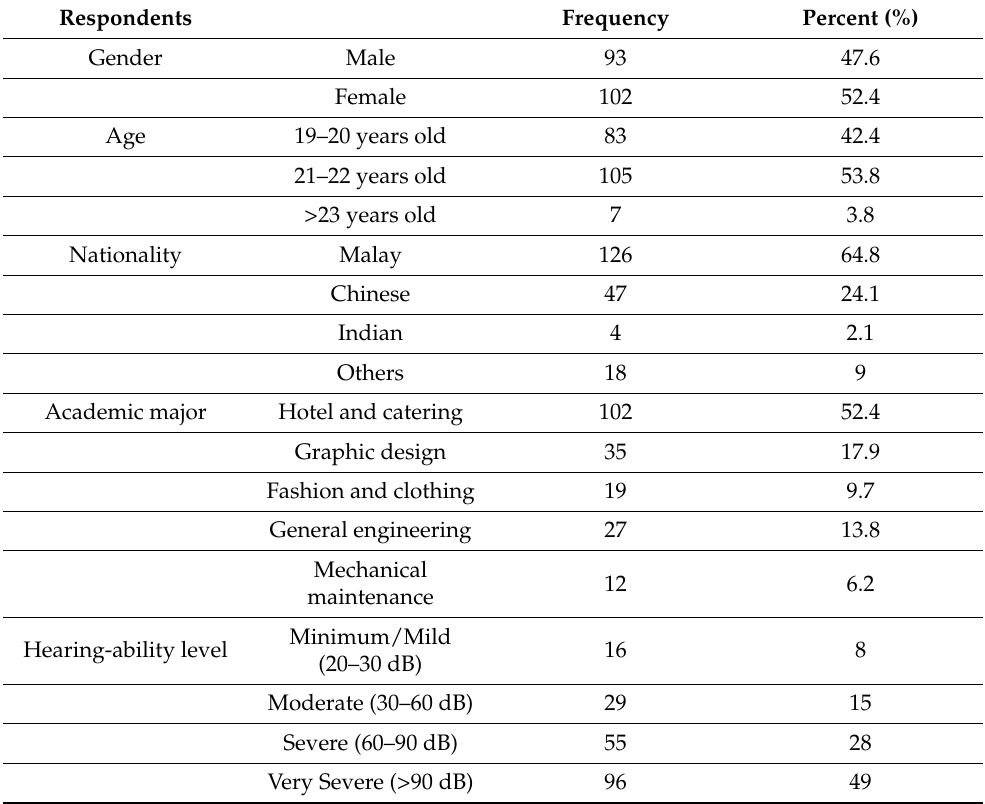
Table 1. Demographic characteristics of the